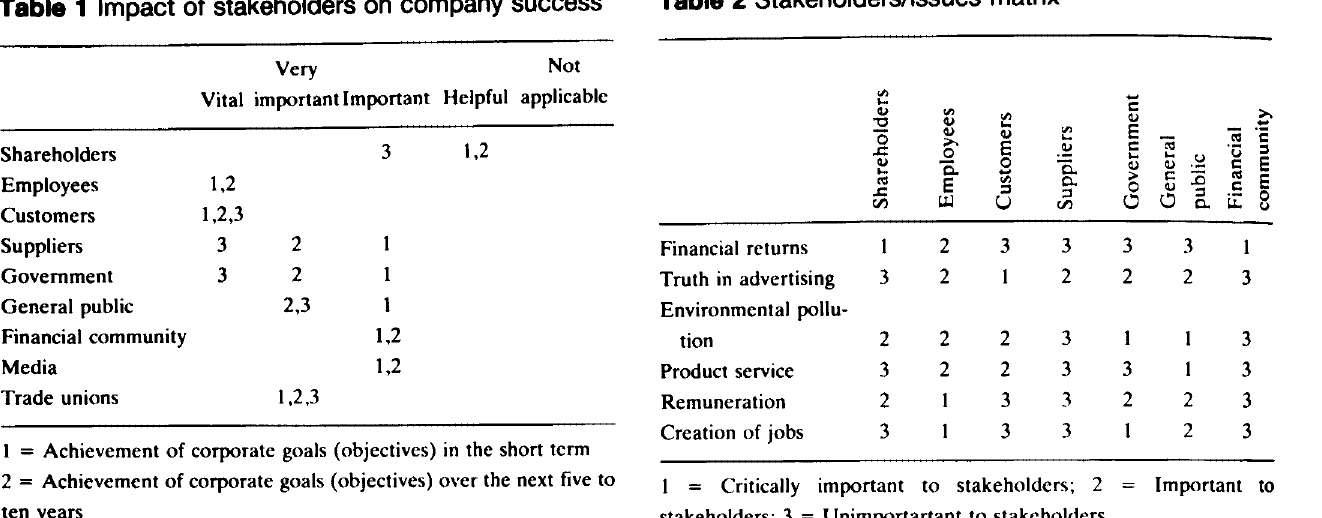
Table 1 Impact of stakeholders on company